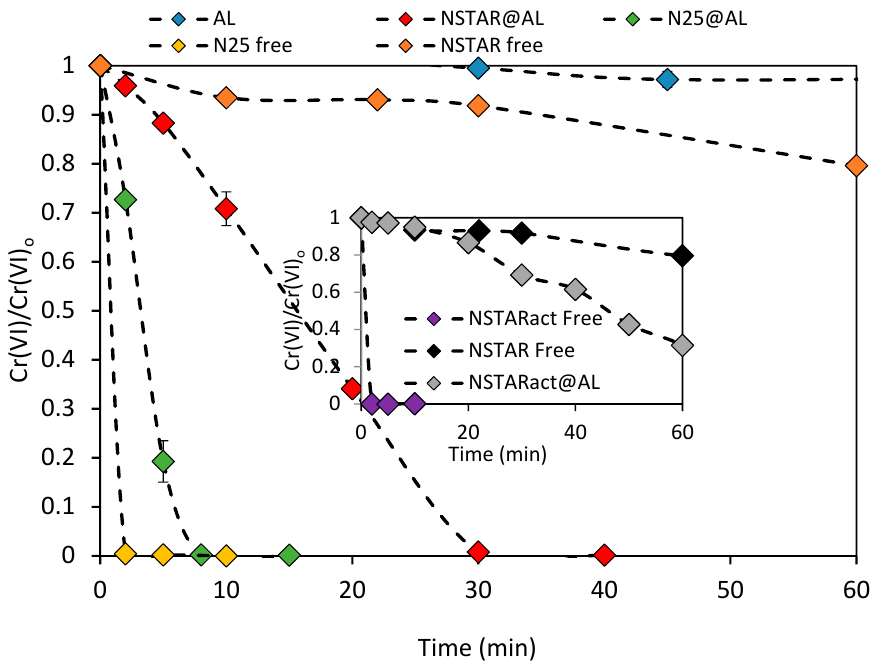
Figure 4. Normalized Cr(VI) removal over time with NSTAR and N25 free and supported in AL, and with bare AL beads. Insert: Normalized Cr(VI) removal over time with free activated NSTAR (NSTARact), inactivated NSTAR, and immobilized activated NSTAR (NSTARact@AL). [Cr(VI)] 64 µM, nZVI@AL = 1 g, MR (Fe:Cr) = 5, pH 3, T = 25 °C, AL = KT.